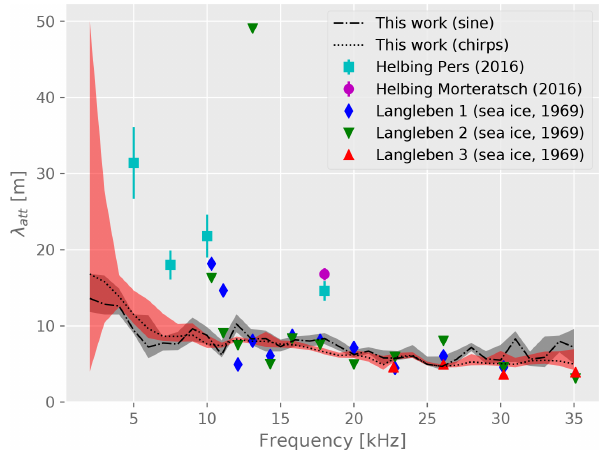
Figure 15. Comparison of our measurement to the results from Lan- gleben (1969) for sea ice and Helbing et al. (2016). Shown are our results based on sine bursts (dark grey band) as well as chirps (light red band) and the other reported results as data